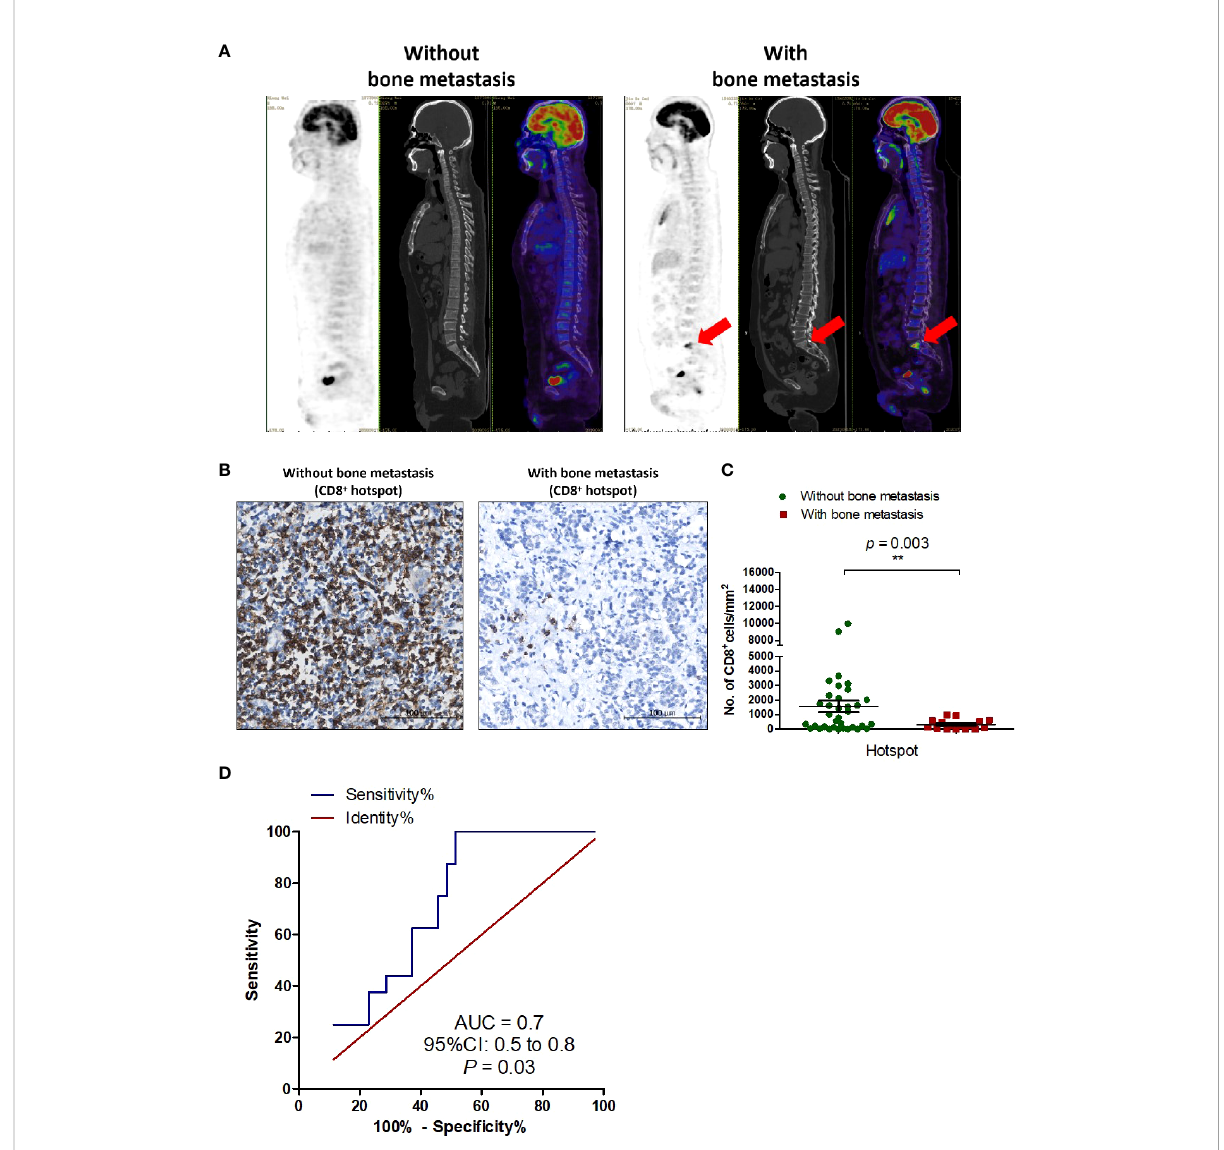
FIGURE 3 CD8 + TILs are a potential immunological marker for predicting bone metastasis in T-NEN. (A) Representative 18 F-FDG PET/CT scan imaging of T- NEN patients with or without bone metastasis. (B) Representative IHC images showing CD8 + TILs deposition in T-NEN with and without bone metastasis. (C) Level of CD8 + TILs (hotspot of CD8 + cells/mm 2 ) was quanti fi ed in each case. Scatter plots of CD8 + hotspot scores in patients with bone metastasis (n = 16) and without bone metastasis (n = 35) were displayed and comparison analysis was performed using the unpaired t -test. Data represent the mean ± SEM, ** p < 0.01. (D) ROC was plotted to assess the predictive capacity of CD8 + TILs to predict bone